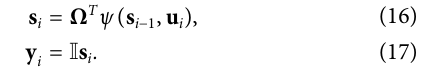
Frontiers in Arti fi cial Intelligence |